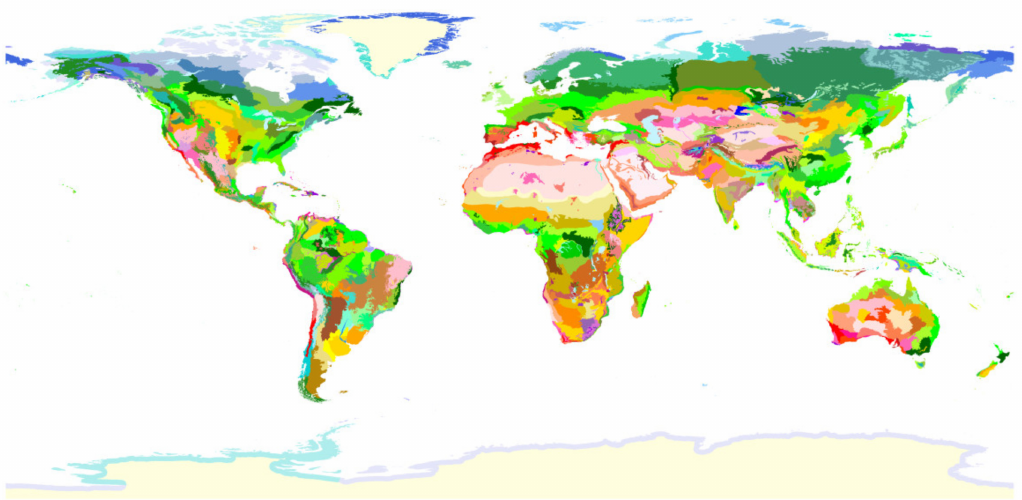
Figure 3. Map of 867 global ecological zones (different colors indicate different